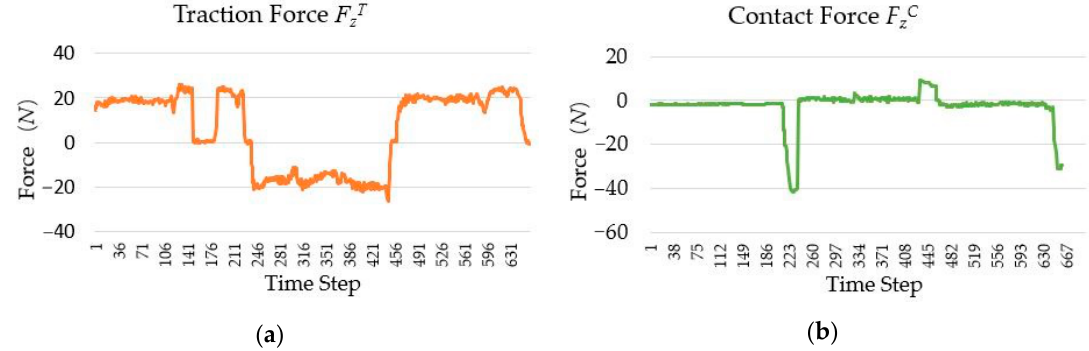
Figure 25. Robot finish drawer switch with the method human teaches: ( a ) approach to the target; ( b ) grab the target; ( c ) open switch; ( d ) close switch.